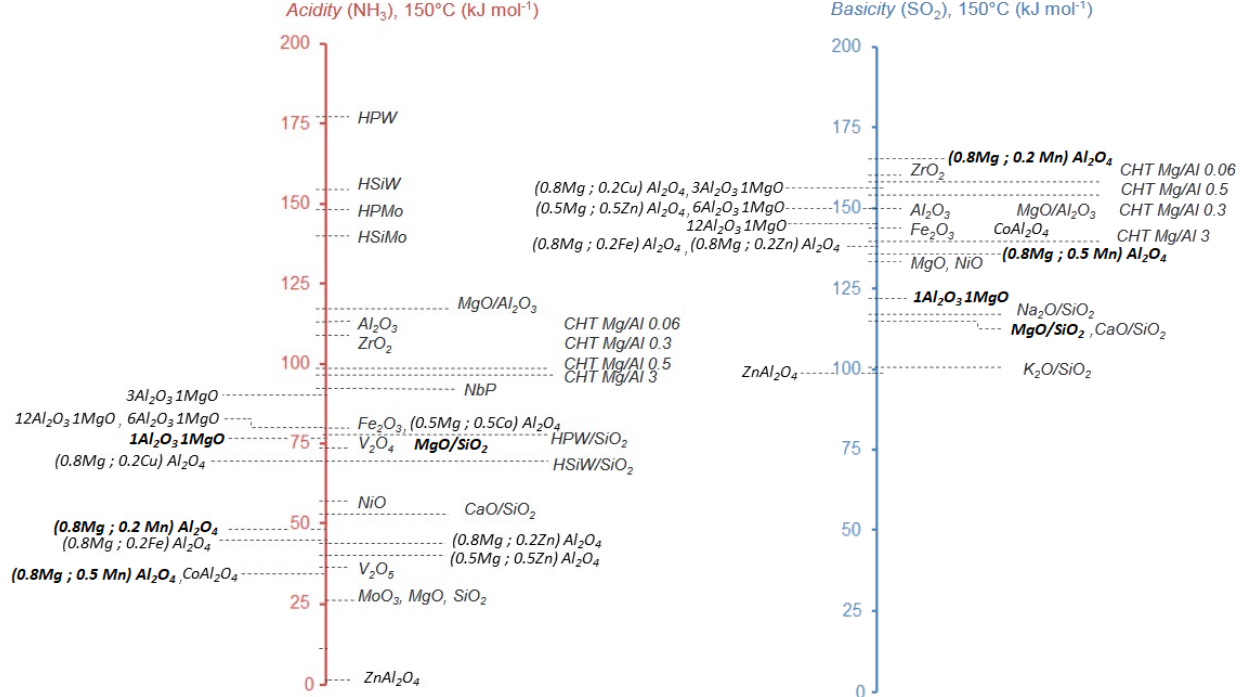
Figure 2. Scales of acidic and basic strength based on the average heat of probe molecule adsorption measured at the plateau of the differential heat curve, or at half coverage when no plateau is observed. See references [39,40] for more details on experimental conditions. Bold: best catalytic systems.